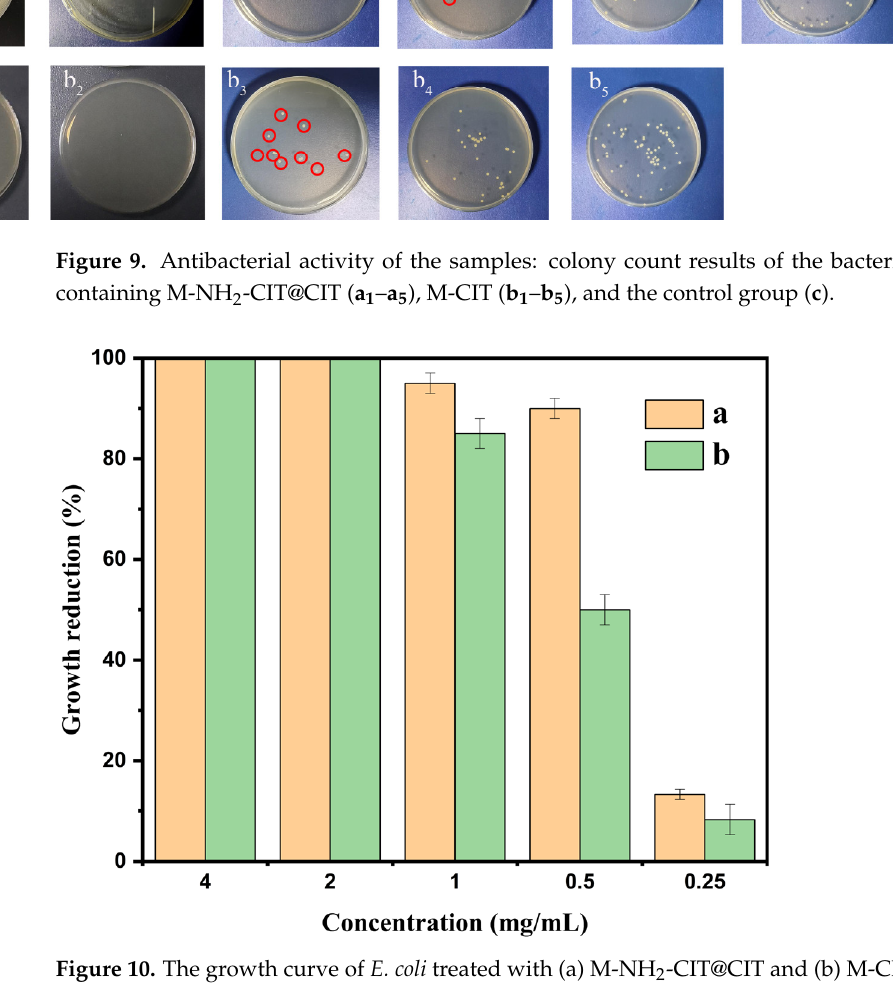
Figure 11. Scanning electron micrograph of E. coli before ( a ) and after ( b ) M-NH 2 -CIT@CIT treatment. 4. Conclusions This study demonstrated an ingenious “essential-oil self-gated” strategy. This pH- responsive bacteriostatic material is controlled by the bacteriostatic drug CIT itself, elim- inating the need for complex “gating factors”. The characterization results demonstrate that this material not only enhances the stability and utilization rate of bacteriostatic drugs, but also attracts more bacteria due to its unique structure and surface charge. Com- pared to M-CIT, M-NH 2 -CIT@CIT achieves higher CIT load capacity as it is self-gated by CIT. This leads to reduced impact on food since less bacteriostatic material is needed for effective bacteriostasis. The “CIT-self-gated” system of M-NH 2 -CIT@CIT not only has long-term antimicrobial performance, but also improves the antimicrobial efficiency of